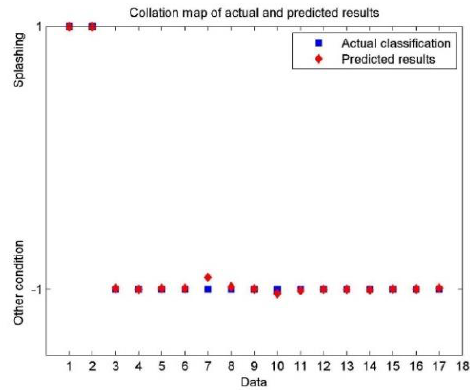
Figure 12. The collation map of actual and predicted results.